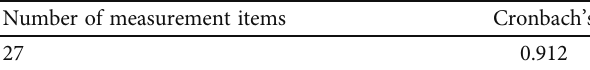
Table 3: Results of overall reliability analysis.